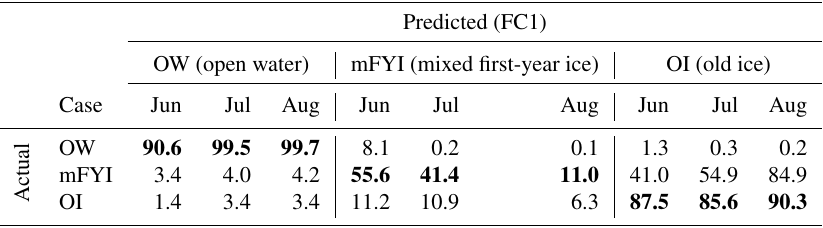
Table 9. Confusion matrix of the three-class RF classifier which was trained with the DS1 summer dataset and applied to the DS2 summer dataset of each month. The bold font indicates where the classification was done correctly. Predicted (FC1) OW (open water) mFYI (mixed first-year ice) OI (old ice) Case Jun